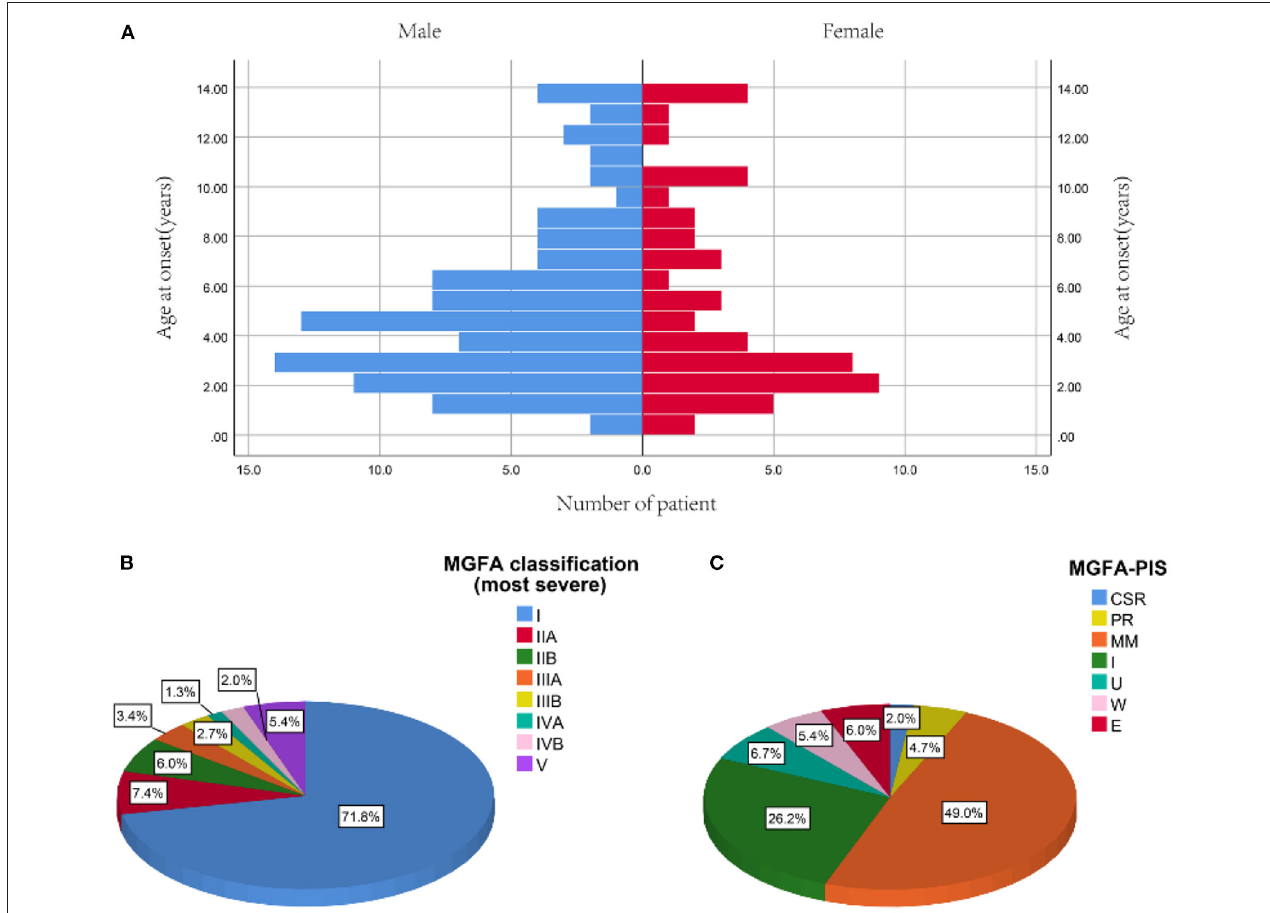
FIGURE 2 | Profiles of study participants. (A) Distribution of onset age between male and female. (B) The most severe MGFA classification before tacrolimus administration. (C) MGFA-PIS on the last follow-up [median 12.9 years (IQR: 6.9, 19.2) from diagnosis]. Data are presented as the number or proportion of patients in each category. CSR, complete stable remission; E, exacerbation; MGFA, Myasthenia Gravis Foundation of America; MM, minimal manifestation; PIS, post-intervention state; PR, pharmacologic remission; U, unchanged; W,